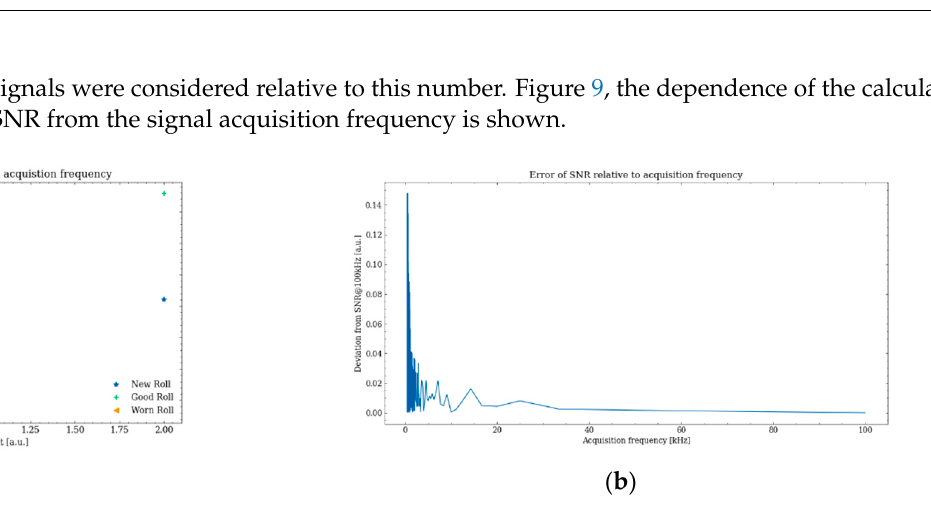
12 of 15 size. Triangle: Worn roll with strong wear marks of approximately 70 µm in size. Source: own-elab- oration. Based on the current results, a method for the monitoring of the tool wear in roller burnishing can be developed by monitoring the signal-to-noise ratio of the tool. Although one of the tested rolls showed only small wear marks, which were only about 1 µm in size, a decrease in the SNR of 3.8% on average was observed in all three trials. A more strongly worn roll yielded an even higher decrease in the SNR of 15.6% and could therefore be clearly distinguished from the new and also from the slightly worn roll. If a corresponding evaluation system is built into the roller burnishing tool, machining processes can be in- terrupted due to the occurrence of wear, and the production of defect parts can be drasti- cally decreased. 4.3. Communication Benchmark For a meaningful evaluation of the communication performance, the requirements from the process side to the signal acquisition have to be defined. As was shown in Section 4.1, the signal-to-noise ratio can serve as a sensible metric to distinguish a worn roll from a new roll. Thus, the necessary acquisition frequency for the determination of the SNR needs to be elaborated to derive appropriate communication methods.